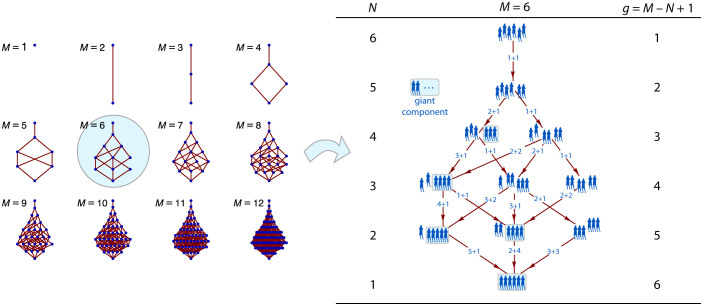
The ensemble of discrete binary aggregation graphs (M = 1 through 12 shown).Each graph starts with M unattached monomers at the top and ends with a single cluster at the bottom. The graph M = 6 is shown in detail on the right. Nodes represent distributions; arrows point from the parent distribution to the offspring and are labelled by the sizes of the two clusters whose merging produces the offspring. All distributions at fixed N constitute the (M, N) ensemble. The giant component (highlighted) is identified as the cluster in the size region i > (M − N + 1)/2 + 1. At most one cluster can exist in the giant region13.